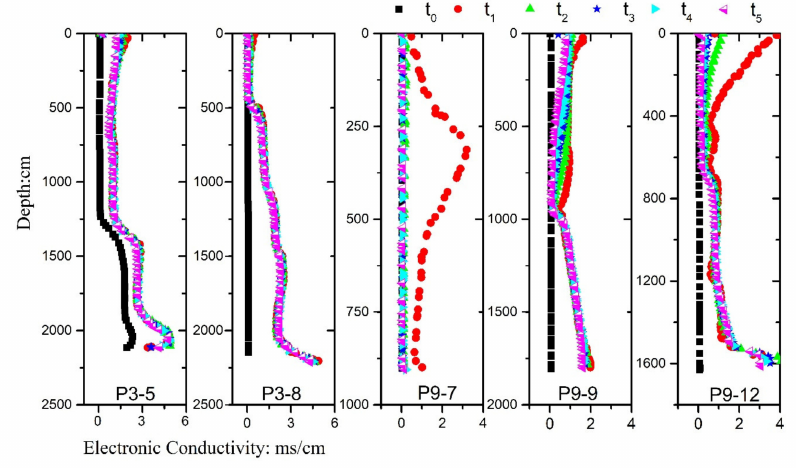
Figure 7. Overlapped EC profiles of boreholes P3-5, P3-8, P9-7, P9-9, and P9-12 at different times.